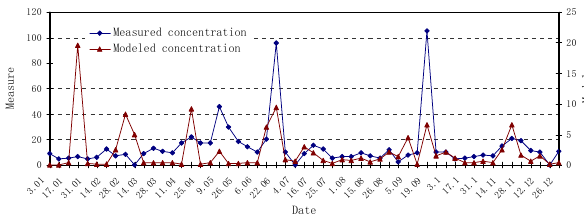
Fig. 10. Vertical cross section of CanMETOP modeled zonal-mean daily lindane air concentration (pg m -3 ) from the surface to 7000m height for April 1 – 10 1997 (from top to bottom), averaged over longitude 110 ˚ E to 140 ˚ W.